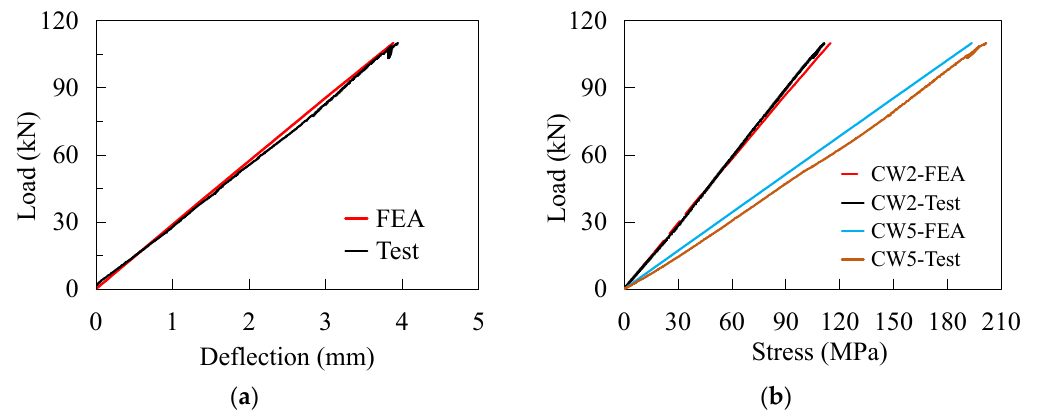
Figure 15. Comparisons of numerical and experimental results: ( a ) load-deflection curves; ( b ) stress at CW2 and CW5.